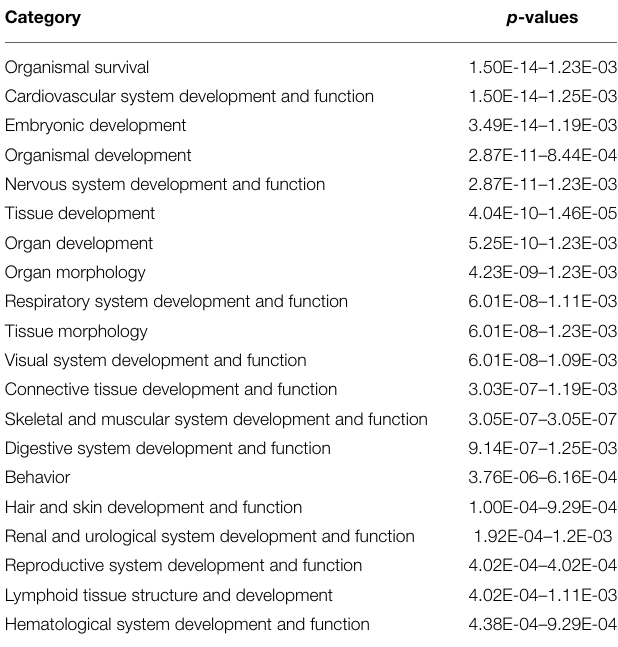
TABLE 2A | Functional annotation under Physiological System Development and Function of genes significantly changed between GD90 and